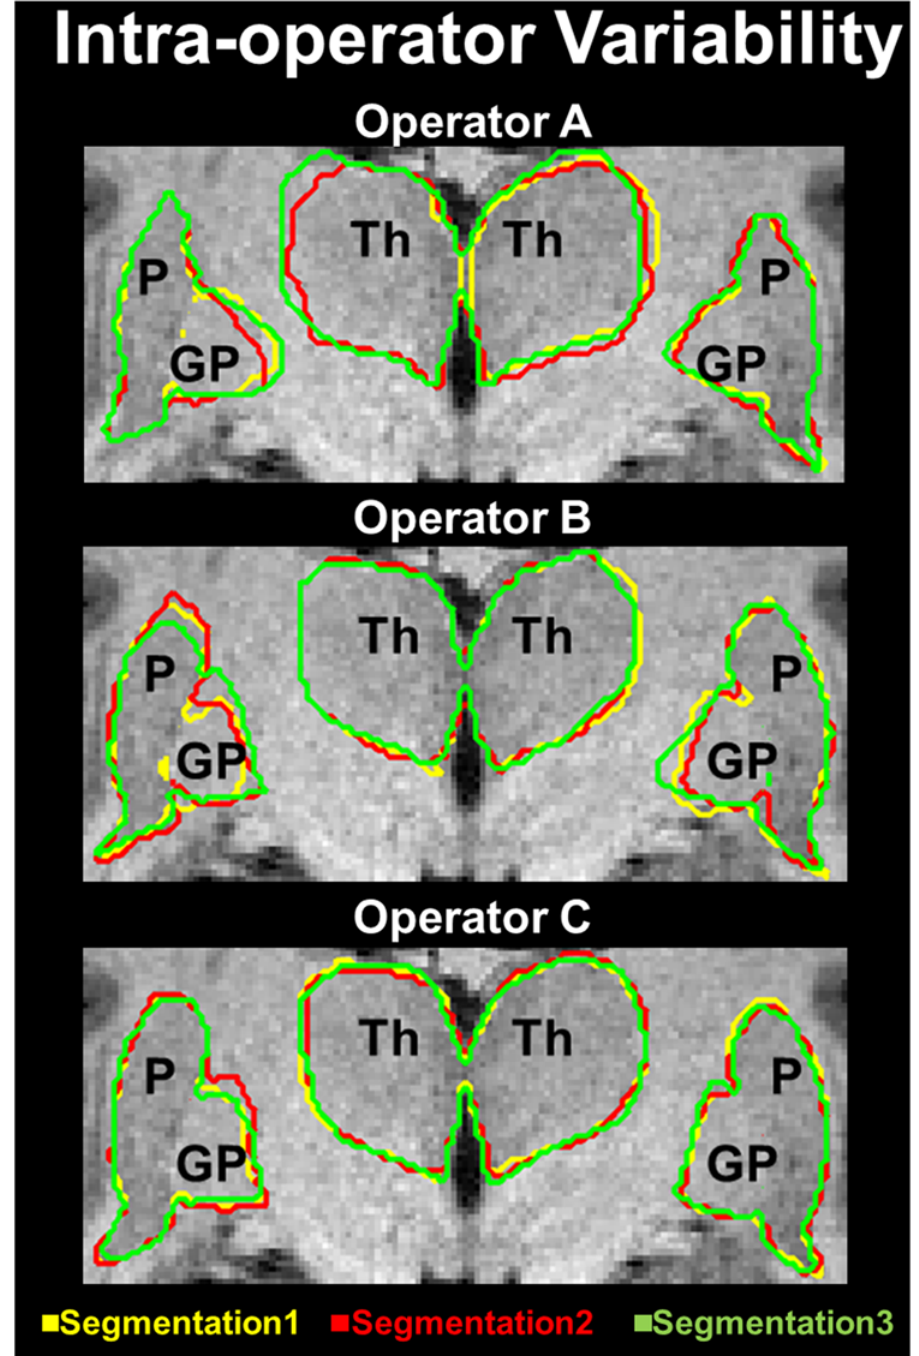
Fig 8. Intra-operator variability. Segmentation1 (yellow), Segmentation2 (red), and Segmentation3 (green) are provided for operators A, B and C on the top, middle, and bottom of the figure, respectively. The intra- operator variability was quantified asking each operator to repeat the segmentation of three selected structures (i.e., the globus pallidus, putamen, and thalamus) three times and measuring the similarity between the outlines performed by each user on different days and a consensus ground truth obtained using the STAPLE